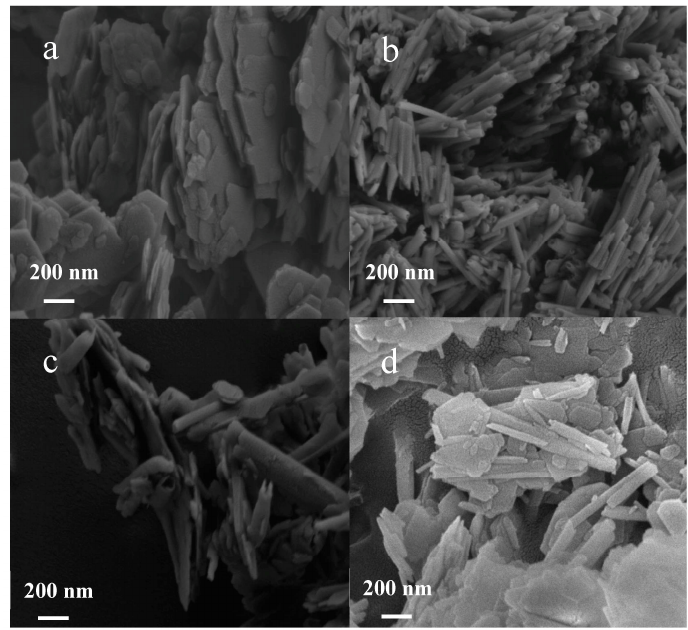
Figure 2. SEM images of kaolinite and halloysite. ( a ) M; ( b ) H; ( c ) S; ( d )